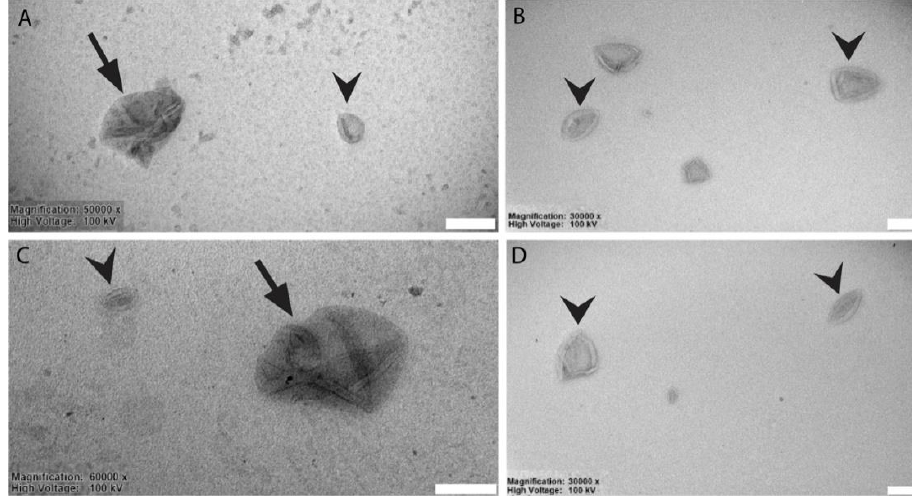
Figure 3. Representative TEM micrographs of liposomes visualized by negative staining. ( A ) immunoliposomes-LLNle (arrows indicate aggregates; arrowheads single liposomes), ( B ) immunoliposomes, ( C ) LLNle-liposomes, ( D ) liposomes. Arrows: aggregates of liposomes; arrowheads single liposomes. Bars = 200 nm.